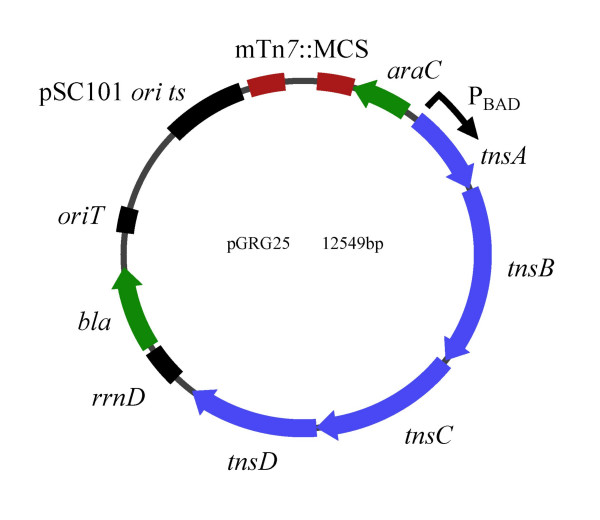
Transposition vector. The vector pGRG25 contains a multiple cloning site (MCS) with unique restriction sites for AvrII, NotI, PacI, and XhoI, flanked by the terminal repeats of Tn7. Cloning of the gene of interest into these sites, in between the Tn7 arms, will result in a plasmid that can be used to insert the transgene into the chromosome. araC is the regulator of the arabinose-inducible promoter PBAD (though in all experiments presented, leaky expression was sufficient). tnsABCD are the genes required for transposition of Tn7. rrnD is the transcription terminator. bla encodes β-lactamase which allows selection of ampicillin resistance when transforming the plasmid into bacteria. oriT is the RP4 conjugal transfer origin. pSC101 ori ts is the temperature sensitive origin of replication which functions at 32°C, but not at 42°C. Vector pGRG36 is identical except for the addition of a SmaI site to the MCS. The sequence of pGRG25 and pGRG36 can be accessed at GenBank (accession # DQ460223).